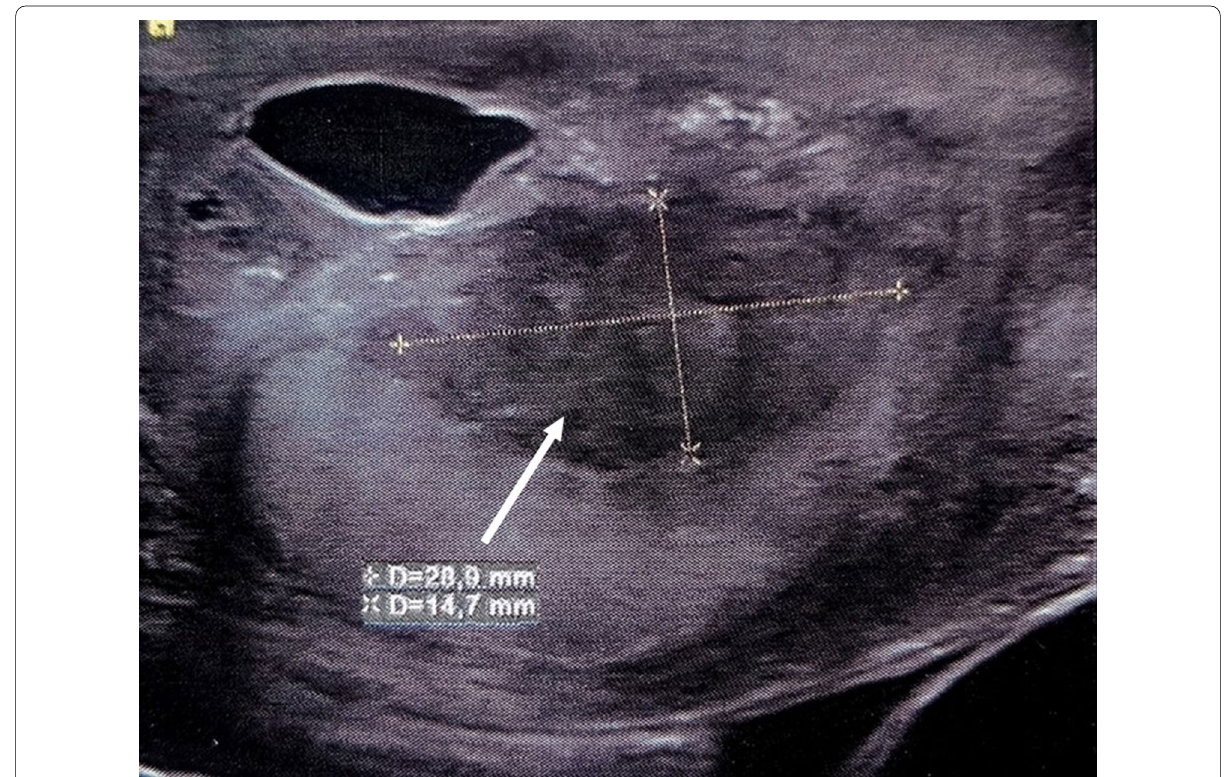
Fig. 1 Ultrasonography of left testis showing a heterogeneous and hypoechoic mass measuring 28.9